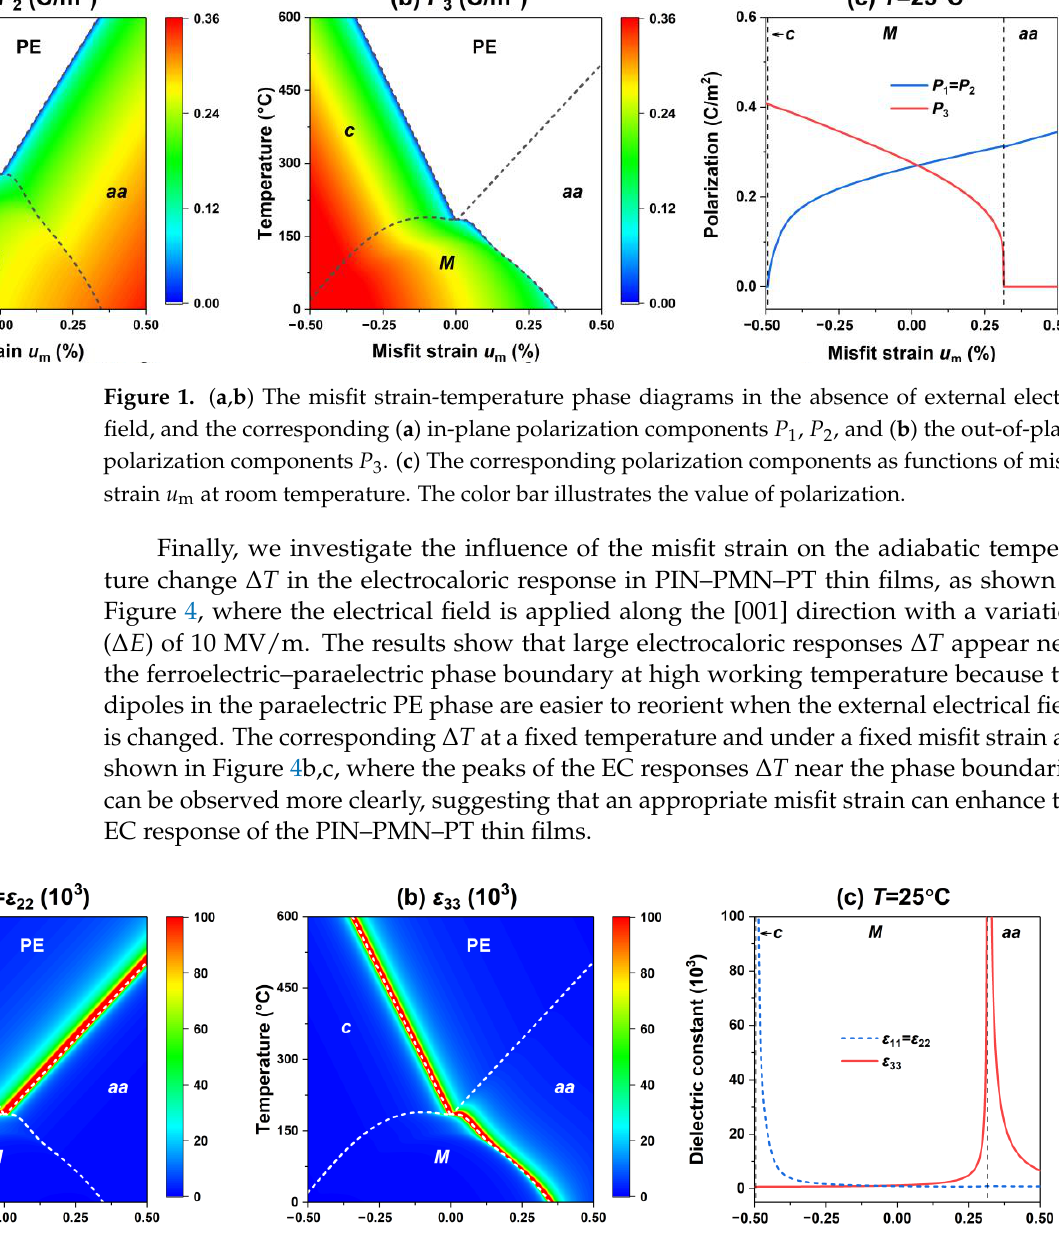
Figure 2. The dielectric constants ( a ) ε 11 and ε 22 , and ( b ) ε 33 as a function of misfit strain and temperature. ( c ) The corresponding dielectric constants as functions of misfit strain u m at room